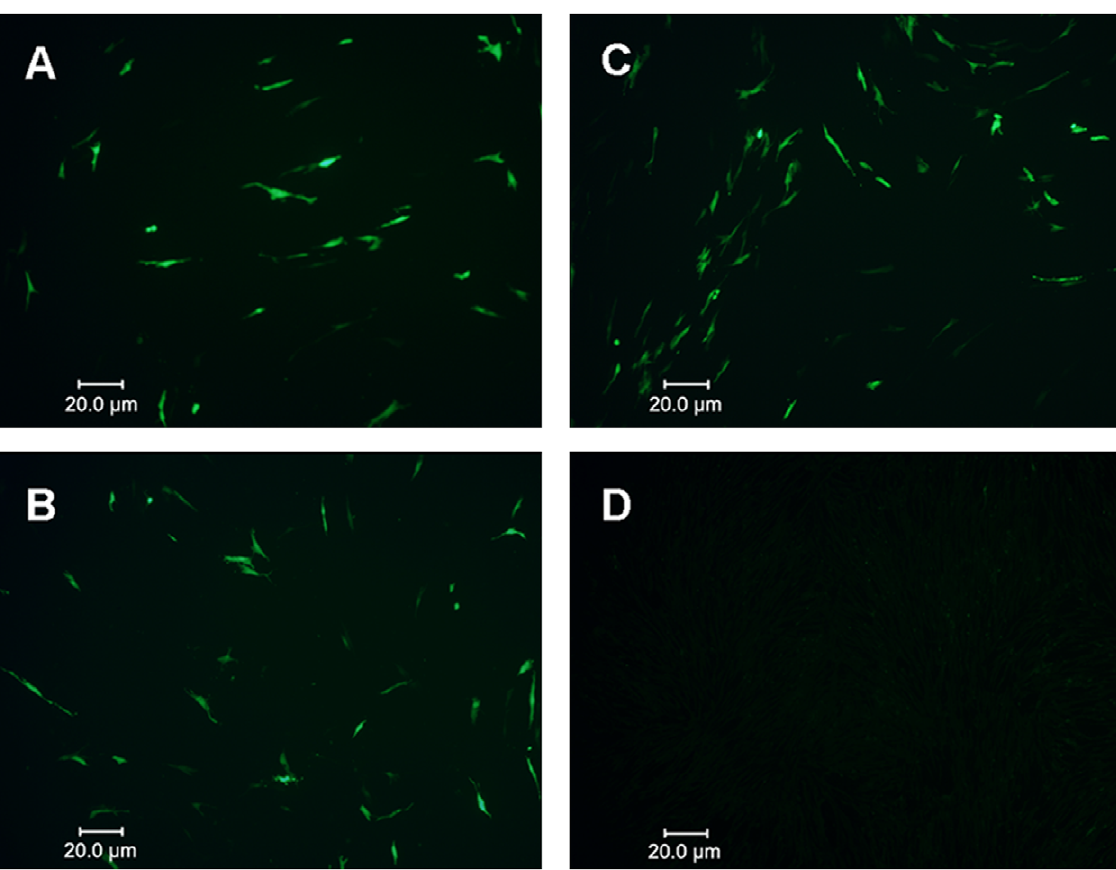
Figure 4. Cell culture isolation of REV from the selected vaccines. (A) CEF inoculated with dilution of MD-CVI988/Rispens vaccine. (B) CEF inoculated with dilution of ND-LaSota + IB-H120 vaccine. (C) CEF inoculated with dilution of REV-SNV strain. (D) Normal CEF as negative control.